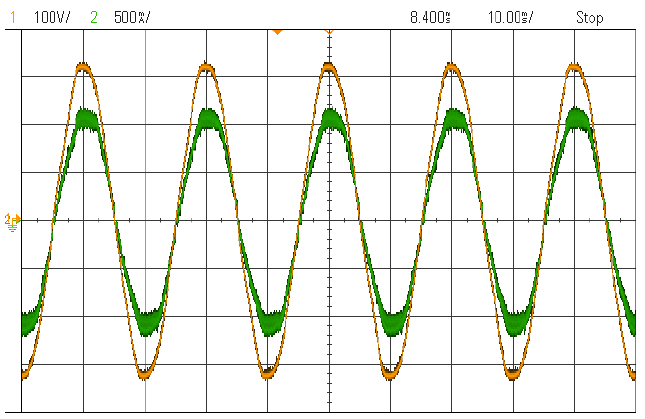
Figure 6. Grid voltage and converter output current (100 V/div, 0.5 A/div, 10 ms/div, V dc = 40 V).